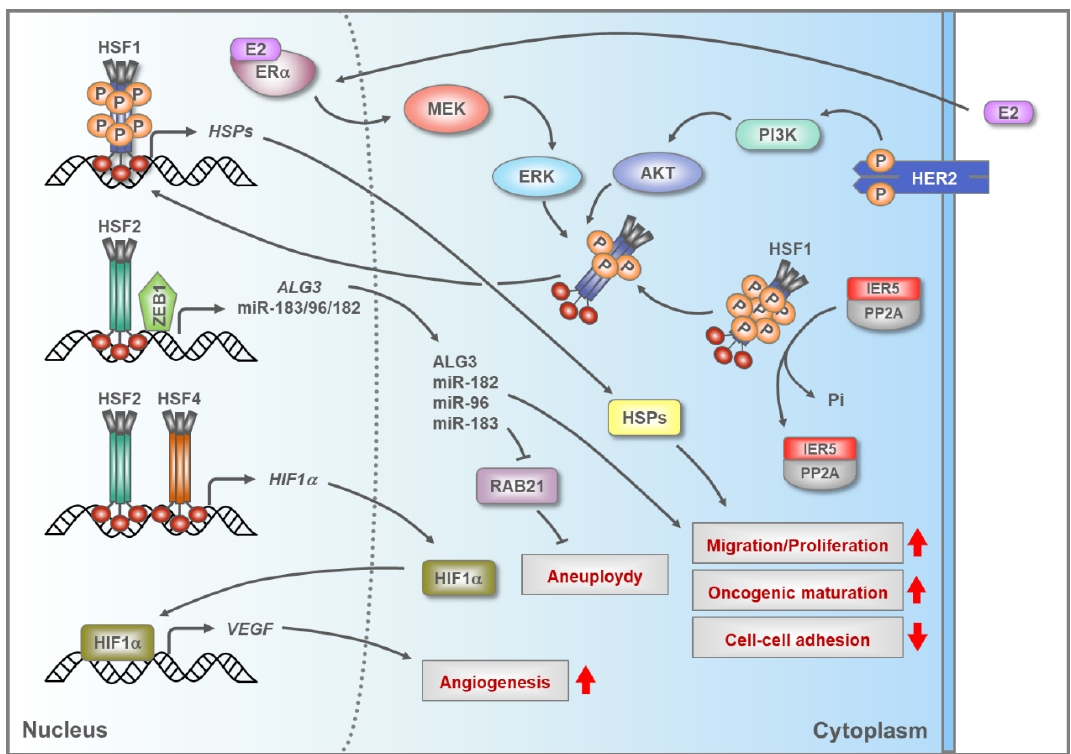
Figure 2. Breast cancer cells use HSFs to drive various tumor-promoting mechanisms. Several mechanisms contribute to the activation of human HSFs in breast cancer. Upon activation, trimeric HSF1, HSF2 and HSF4 bind to DNA and initiate the transcription of their target genes, which are involved in tumorigenesis. Multiple proteins enhance the activation of HSF1 by regulating its phosphorylation status. The hormone 17 β -estradiol (E2) binds to and activates estrogen receptor alpha (ER α ), which leads to HSF1 phosphorylation through the mitogen-activated protein kinases / extracellular signal-regulated kinases (MAPK / ERK) pathway, in which the kinases MEK and ERK increase the phosphorylation of HSF1, most probably in the cytoplasm. Activation of HSF1 is also enhanced by epidermal growth factor receptor 2 (HER2), which increases the phosphorylation of HSF1 by the intermediate kinases phosphatidylinositol 3-kinase (PI3K) and protein kinase B (AKT). Phosphorylated residues in HSF1 that are known to repress the trans-activating capacity of HSF1, are dephosphorylated (Pi) by a complex consisting of the transcription factor immeadiate early response gene 5 protein (IER5) and protein phosphatase 2 (PP2A), thereby promoting HSF1 activation. In the nucleus, once activated, HSF1 induces the transcription of genes encoding heat shock proteins (HSPs), which enhance migration, proliferation, and oncogenic maturation as well as decrease cell–cell adhesion. HSF2 and the transcription factor zinc finger E-box-binding homeobox 1 (ZEB1) cooperatively induce the transcription of pri-mir-183 / 96 / 182, and following post-transcriptional processing, these miRNA molecules stimulate migration and proliferation. For example, mir-183, targets the small GTPase RAB21, a protein that prevents aneuploidy. HSF2 also stimulates the expression of Dol-P-Man:Man(5)GlcNAc(2)-PP-Dol alpha-1,3-mannosyltransferase (ALG3), an enzyme involved in modulating migration and proliferation in breast cancer cells. HSF2 together with HSF4 modulates the transcription of hypoxia-inducible factor 1 alpha (HIF-1 α ), a transcription factor regulating a myriad of genes, including vascular endothelial growth factor (VEGF) that promotes angiogenesis. Abbreviation: P, phosphorylation.